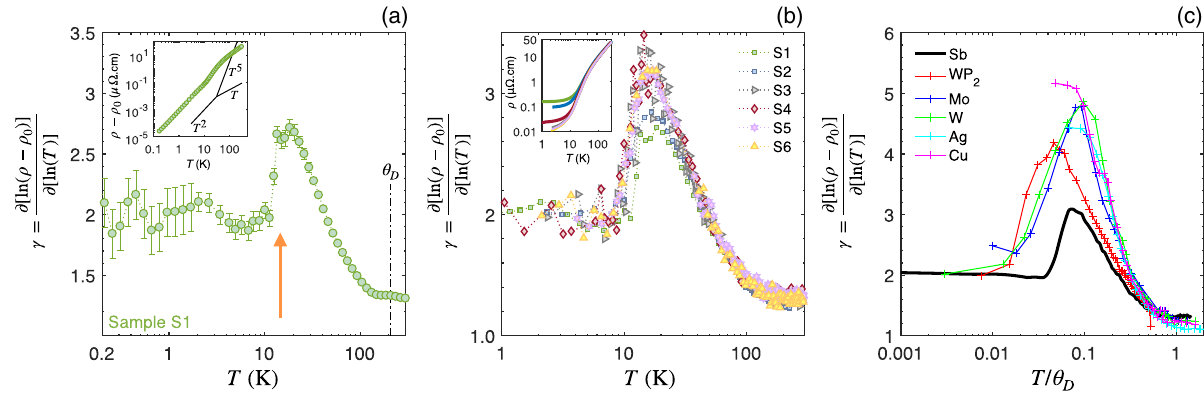
FIG. 6. Resistivity exponent. (a) γ , the exponent of the inelastic resistivity ( ρ ¼ ρ 0 þ A γ T γ ), determined from the logarithmic derivative of ρ − ρ 0 in sample S1 as a function of the temperature. Error bars represent the 95% confidence bounds. The steady increase in γ is abruptly stopped around T ¼ 15 K, marked by an orange arrow. This is the same temperature at which the phonon mean-free path becomes size dependent [arrow in Fig. 2(c)]. (b) The exponent of the inelastic resistivity, γ , in six different Sb samples as a function of the temperature. The inset shows the resistivity of the six samples. (c) Comparison of the temperature dependence of γ in Sb (averaged over the different samples) and five other metals.